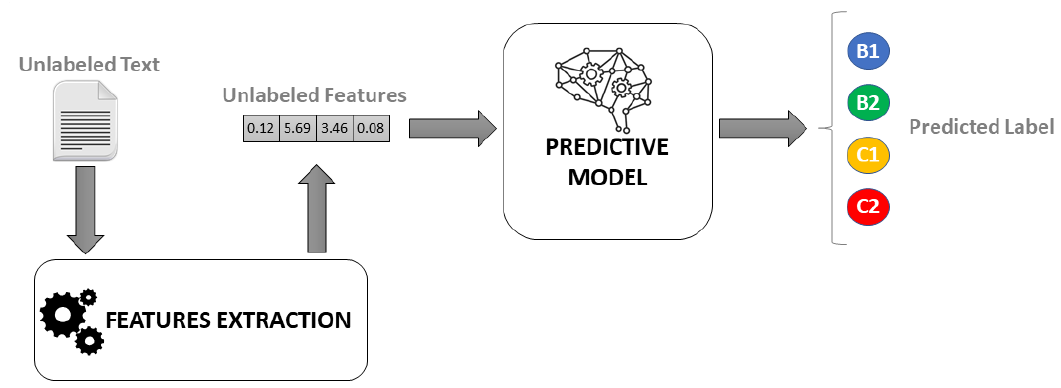
Figure 2. Prediction phase of the classification system.